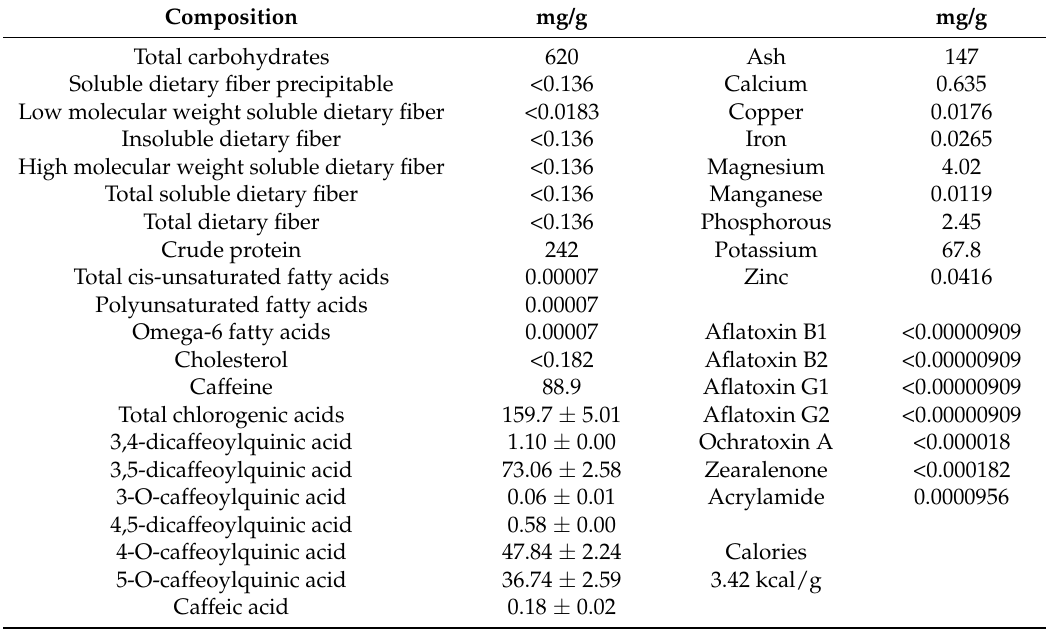
Table 1. Chemical characterization of the green coffee extract (GCE) used in this study. Composition mg/g mg/g Total carbohydrates 620 Ash 147 Soluble dietary fiber precipitable <0.136 Calcium 0.635 Low molecular weight soluble dietary fiber <0.0183 Copper 0.0176 Insoluble dietary fiber <0.136 Iron 0.0265 High molecular weight soluble dietary fiber